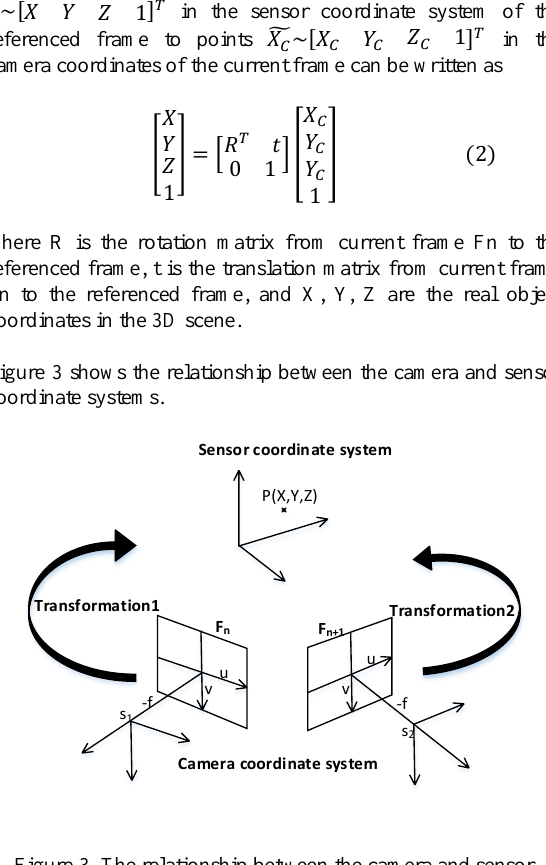
Figure 3. The relationship between the camera and sensor coordinate systems